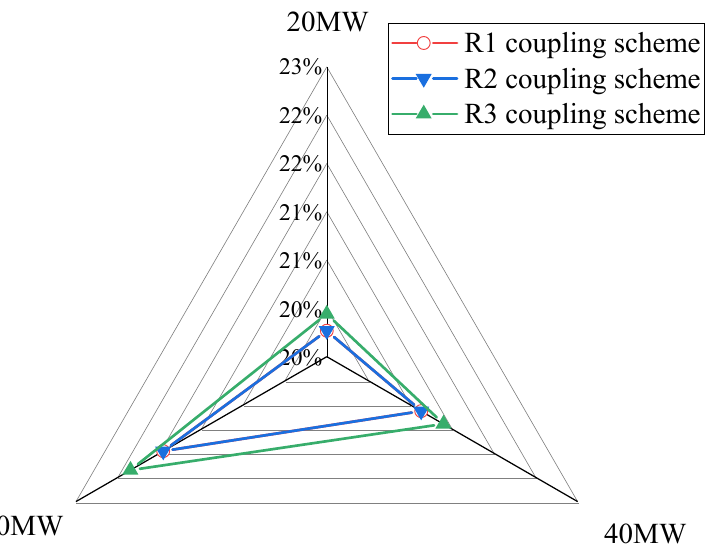
Figure 6. Peak regulating depth of the heat-storage process coupling system.